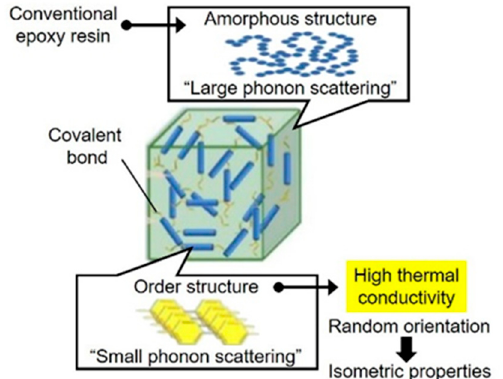
Figure 5. Schematic comparison of the conventional epoxy resin and LC epoxy resin to enhance the thermal conductivity.